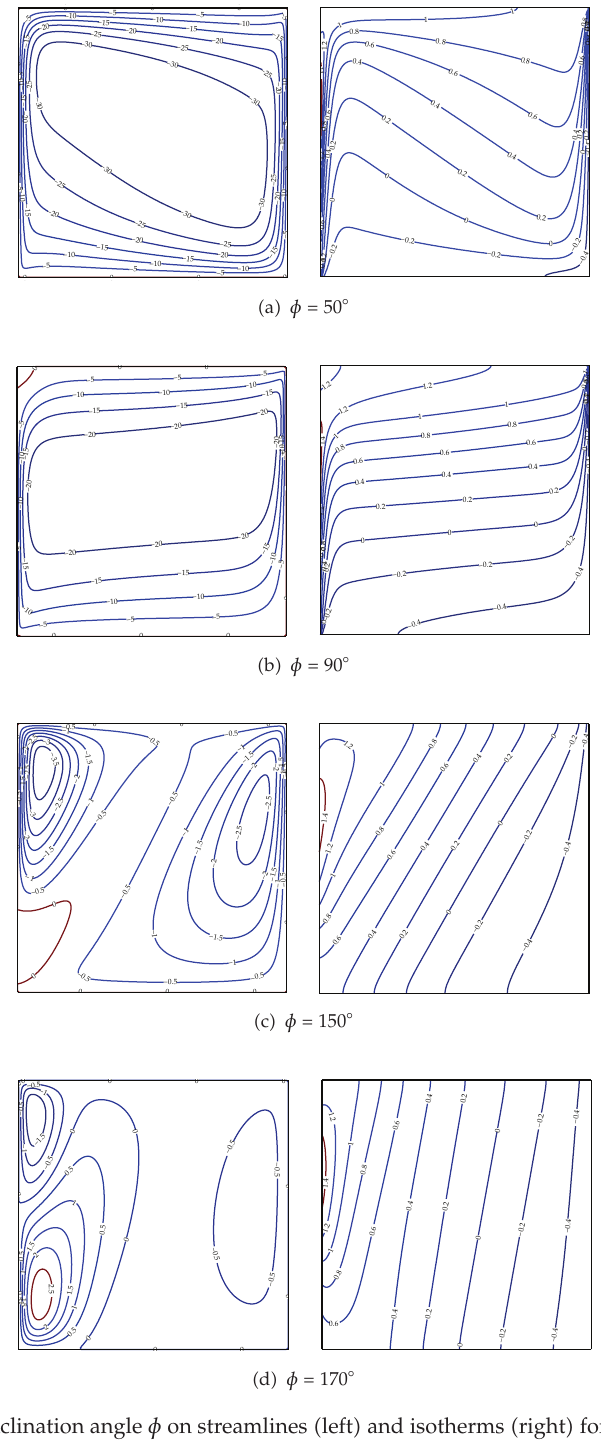
Figure 3: E ff ects of inclination angle φ on streamlines (cid:5) left (cid:6) and isotherms (cid:5) right (cid:6) for ε (cid:8) 0 . 5, κ (cid:8) 0 . 75, and Ra (cid:8)